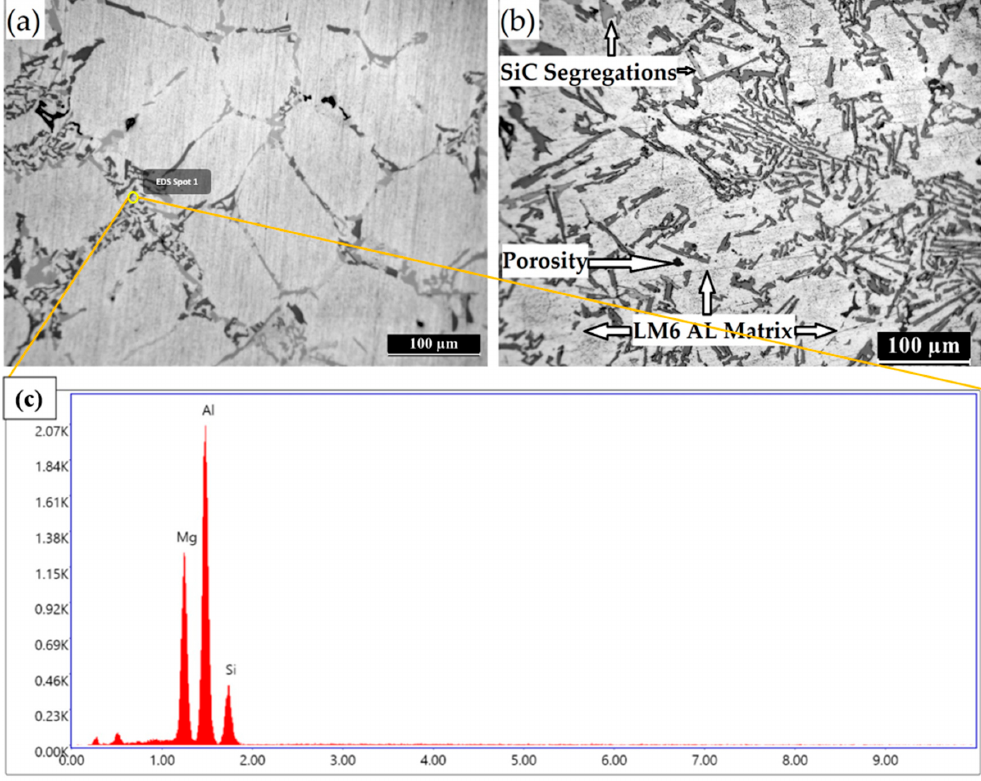
Figure 2. Optical Microscopy Micrograph of ( a ) LM6 base alloy at 200x ( b ) MMC at 200x; and ( c ) corresponding EDS spot analysis LM6 base alloy .